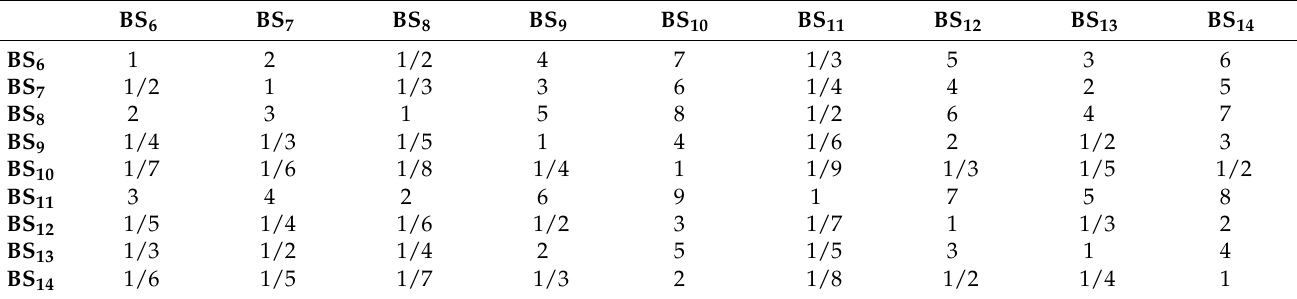
Table A16. The pairwise comparison matrix Admin _ C 4 .